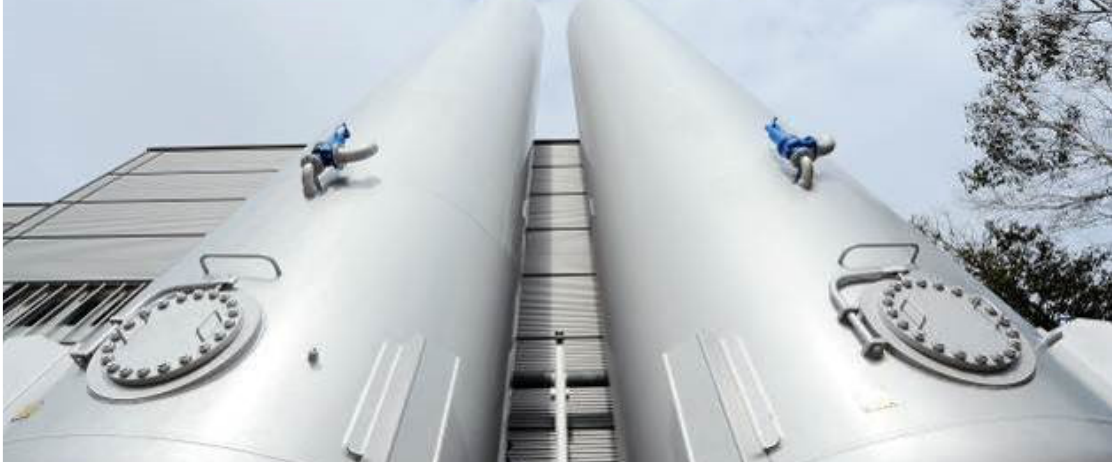
Figure 2: Reservoir pressure containers.